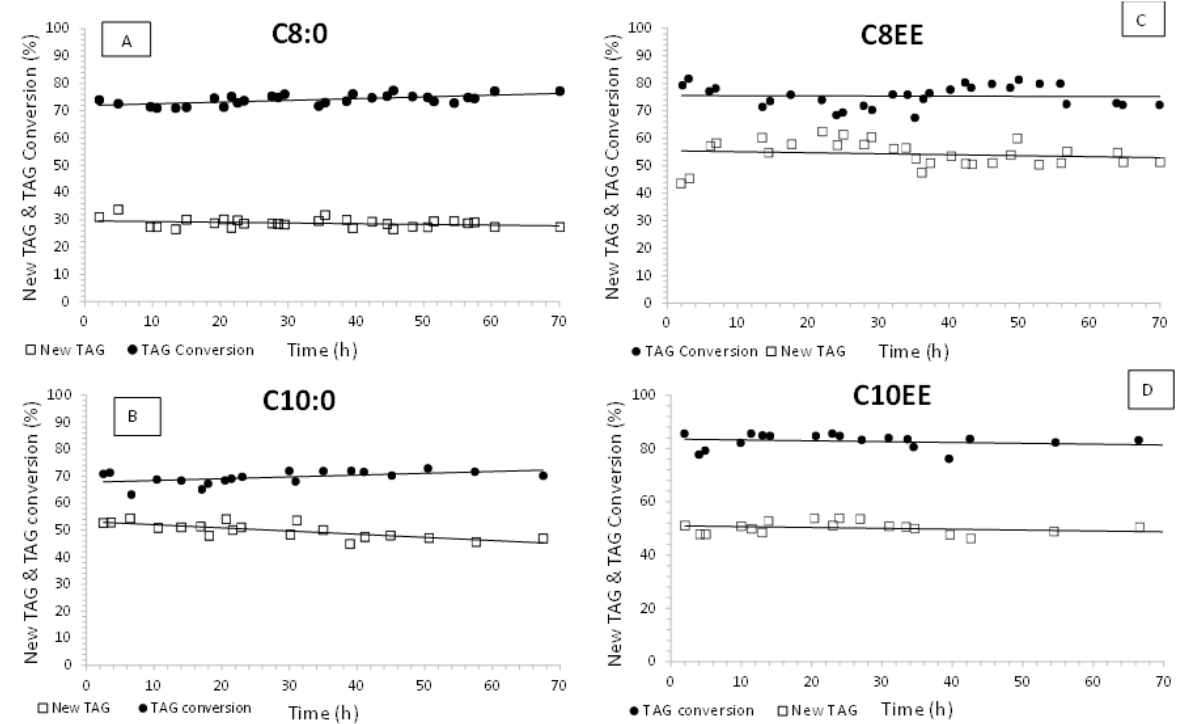
Figure 1. New TAG yield and TAG conversion along continuous acidolysis and interesterification reactions of ( A ) C8:0, ( B ) C10:0, ( C ) C8EE, and ( D ) C10EE, respectively, catalyzed by Lipozyme TL IM biocatalyst.